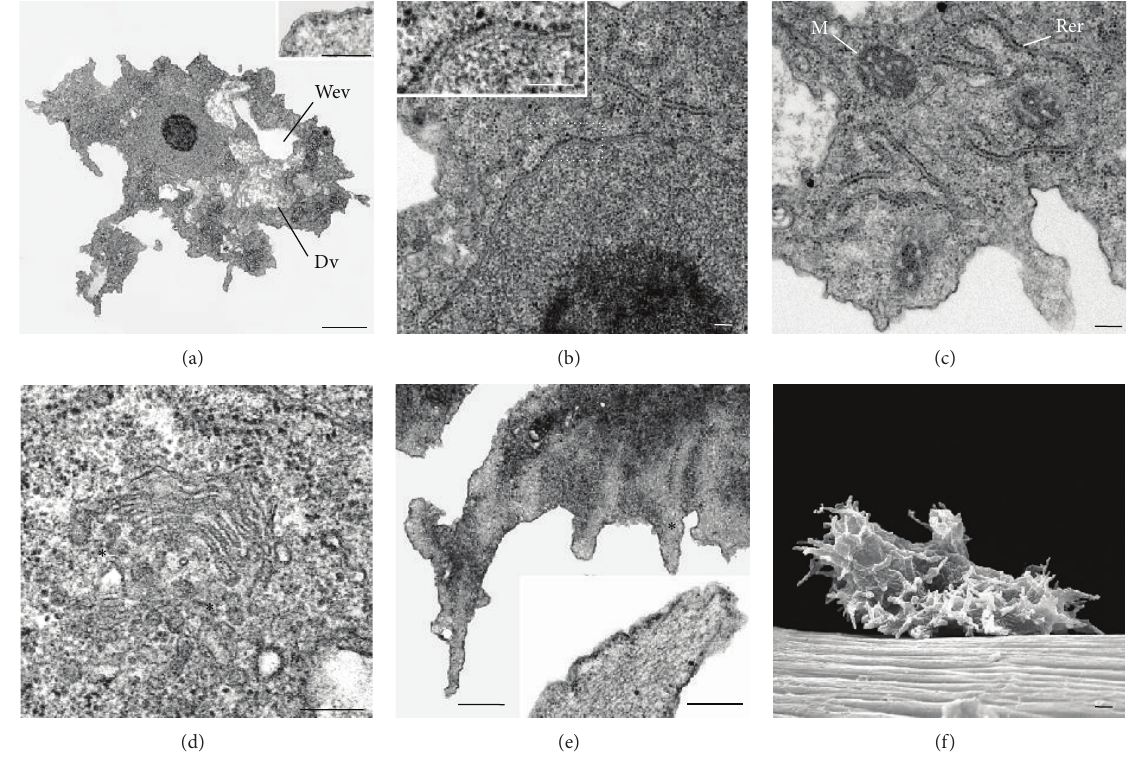
Figure 2: Transmission electron microscopy ((a)–(e)) and scanning electron microscopy (f) of A. griffini trophozoites. (a) Low magnification of an amoeba which shows an extremely irregular profile and a large clearly defined granular round nucleus with a circular electron-dense nucleolus. Numerous digestive vacuoles (Dv) with fibrogranular content and a water expulsion vacuole (Wev) are also observed. The plasma membrane presents its classical three-layered structure (insert). Bar = 2 𝜇 m. Insert = 0.1 𝜇 m. (b) The nuclear envelope is composed of a double membrane with abundant ribosomes on the external side of the envelope. Bar = 0.2 𝜇 m. Insert = 0.1 𝜇 m. (c) Mitochondria (M) and numerous profiles of rough endoplasmic reticulum (Rer) located near the edge of the cell were clearly defined. Bar = 0.2 𝜇 m. (d) Golgi system with various stacked cisternae. Some membrane-bound vesicles were present in the concave area (asterisks). Bar = 0.2 𝜇 m. (e) Fibrogranular matrix located in the periphery of a trophozoite. The asterisk indicates a similar region observed at high magnification where abundant actin filaments are observed. Bar = 1.0 𝜇 m. Insert = 0.2 𝜇 m. (f) A trophozoite in a lateral view is shown in a displacing position with a portion of the cell body facing upwards. The rough and extremely uneven cell surface exhibits abundant cytoplasmic projections, mostly in the manner of filopodia. Bar = 1.0 𝜇